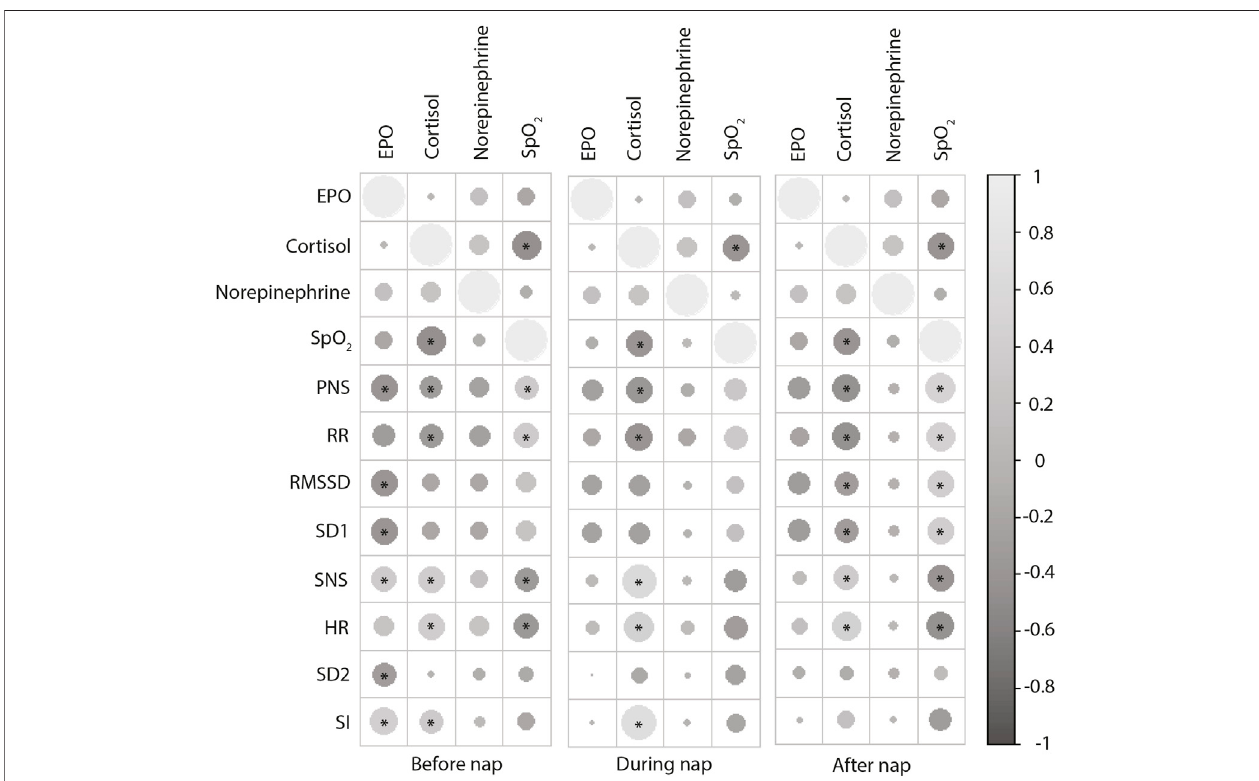
FIGURE2| Correlationsofafter nap stresshormonelevels (EPO, cortisol,norepinephrine) with HRV parameters measuredafter, during and after the nap.Positive correlations are displayed in light gray and negative correlations in dark gray. Circle size and intensity are proportional to the correlation coef fi cients. * p < 0.05 (Pearson ’ s